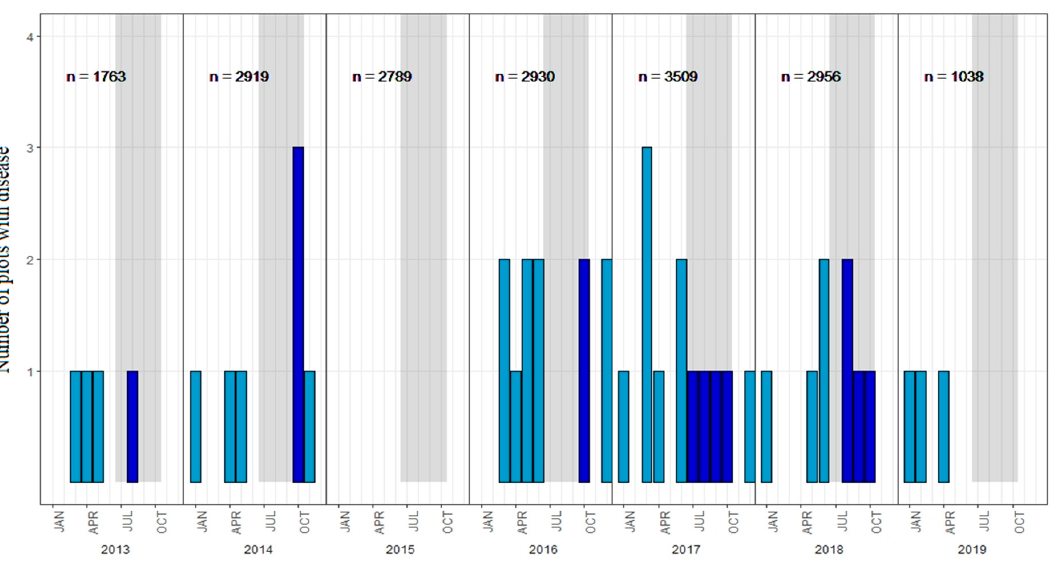
Figure 3. Frequency of monthly foliar disease per FIA plot between 2013 and 2019. Observations from the blue bars in the shaded region (between months July to October) were excluded from both the individual tree level mixed model and the MaxEnt analyses.